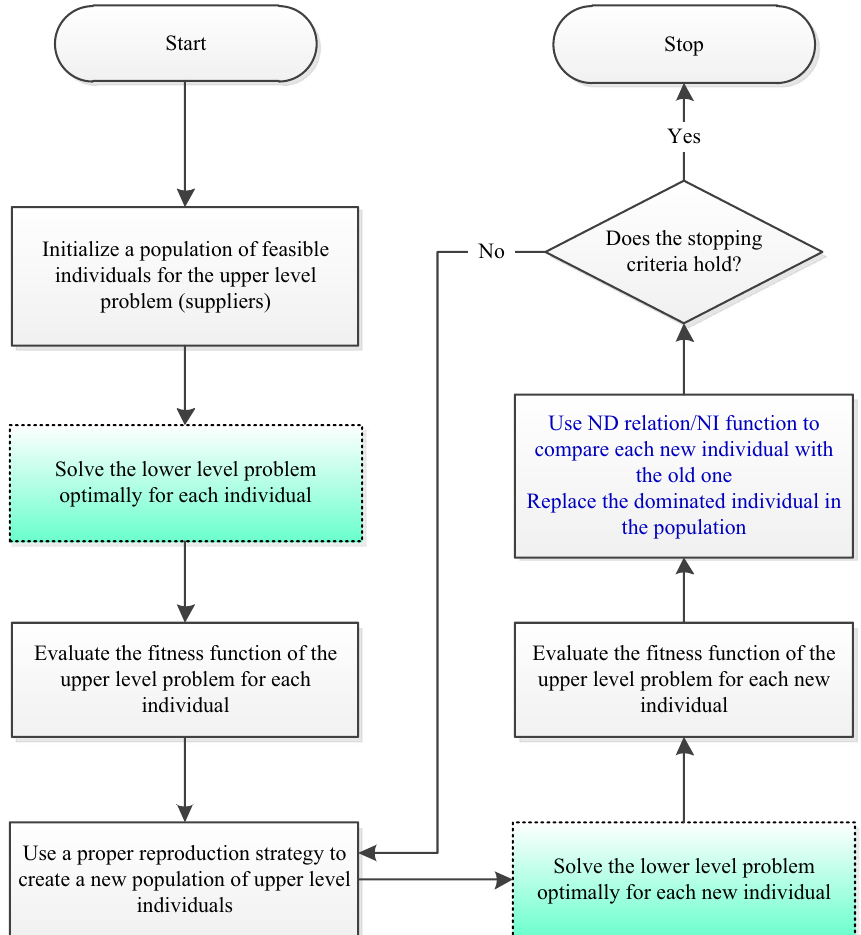
Fig. 3 The flowchart of ND-MLSG-PBM and NI-MLSG-PBM